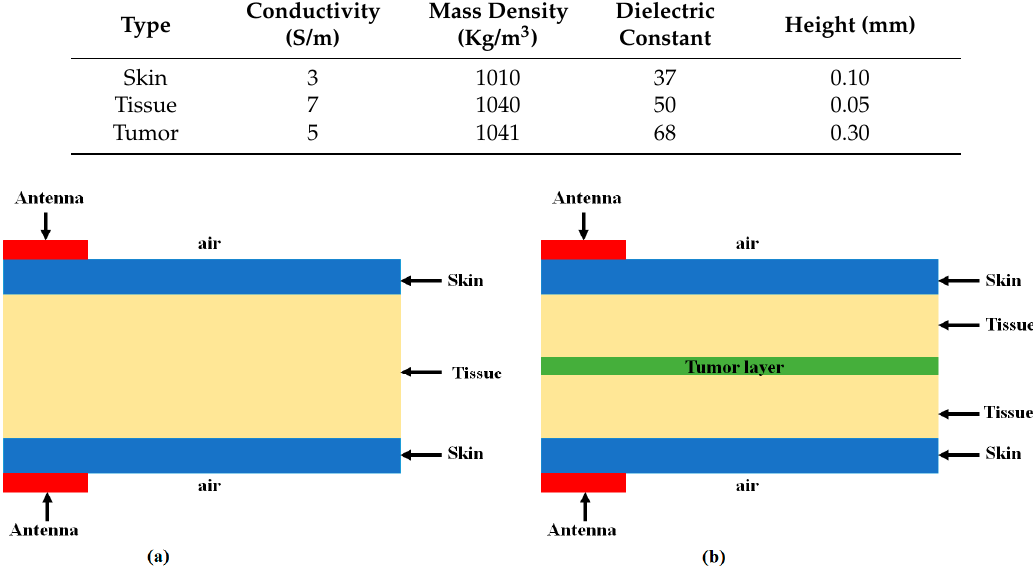
Table 2. Dielectric properties of the stacked organic layers, i.e., tissue, skin, and tumor [13]. Type